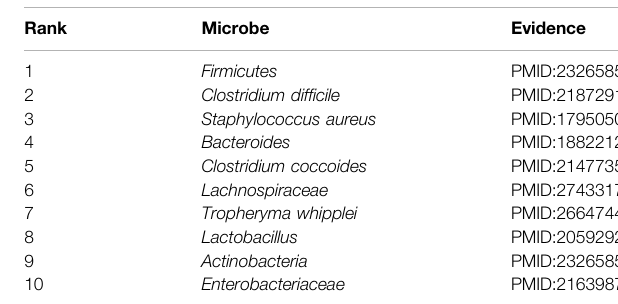
TABLE 4 | The validation results of the top 10 predicted asthma-related microbes by implementing